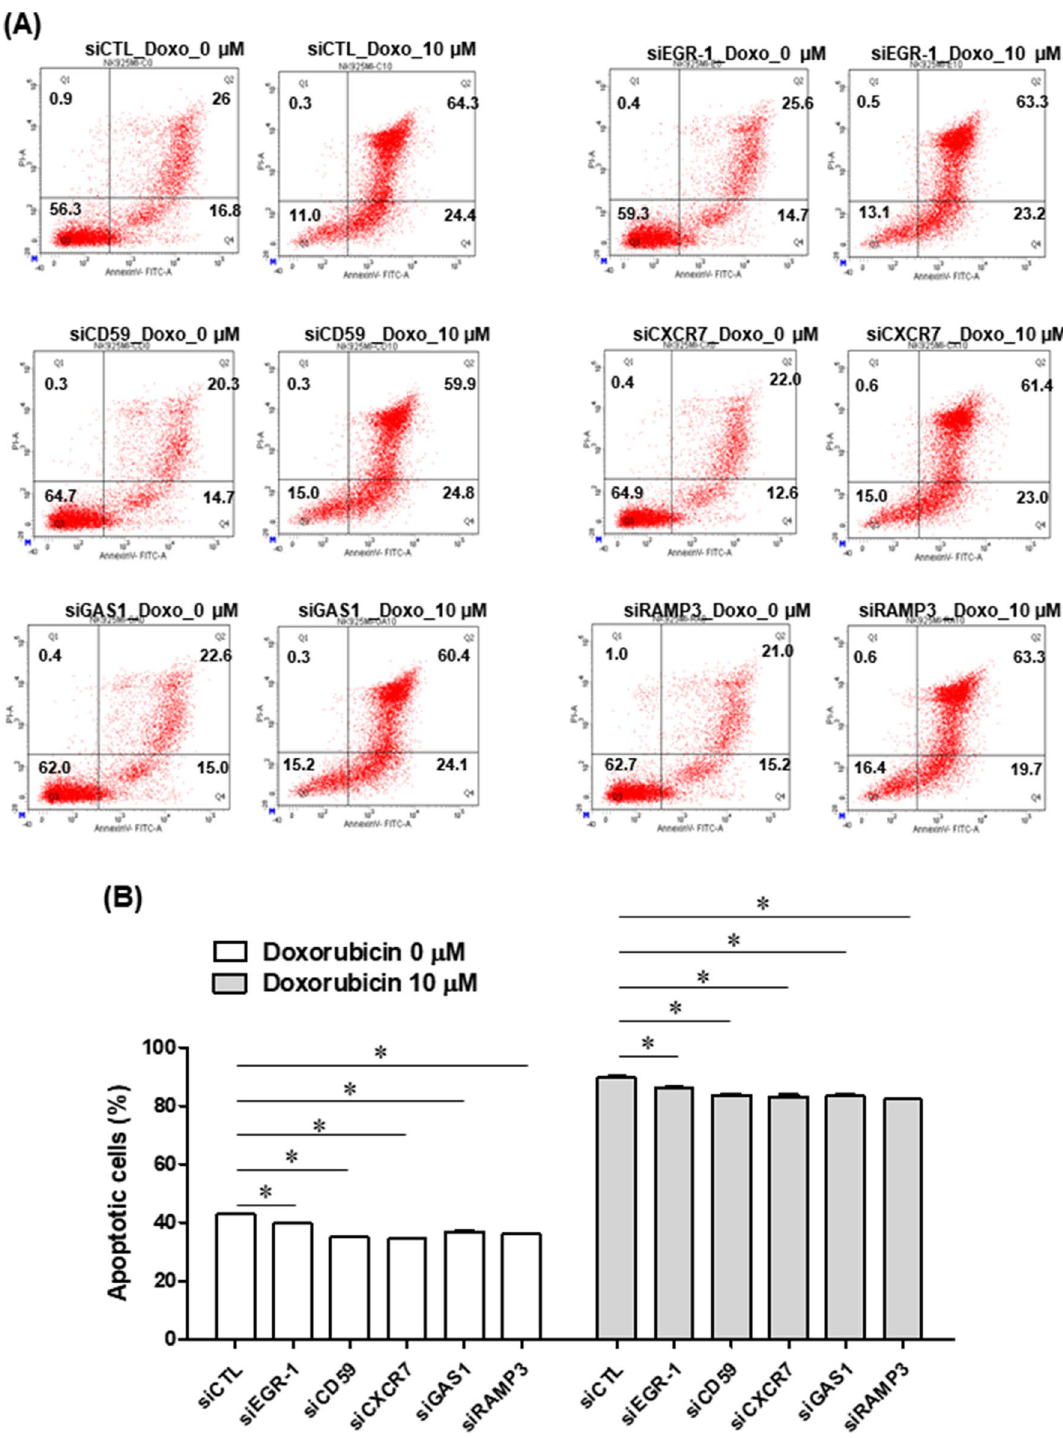
Figure 6. NK92MI cells were transfected with siRNA control, siEGR-1, siCD59, siCXCR7, siGAS1, and siRAMP3; 48 h later, doxorubicin (10 µM) was applied for 24 h ( A ). Dot plots are separated into four quadrants: Q1 (Annexin V-/PI + : cell death), Q2 (Annexin V + /PI + : late apoptotic cells), Q3 (Annexin V − /PI − : living cells), and Q4 (Annexin V + /PI- : early apoptotic cells). The percentage of apoptotic cells measured using flow cytometry ( B ). Values are presented as mean ± SEM (n = 3). P values were determined using Student’s t-test. * P < 0.05 versus siCTL siRNA, small interfering